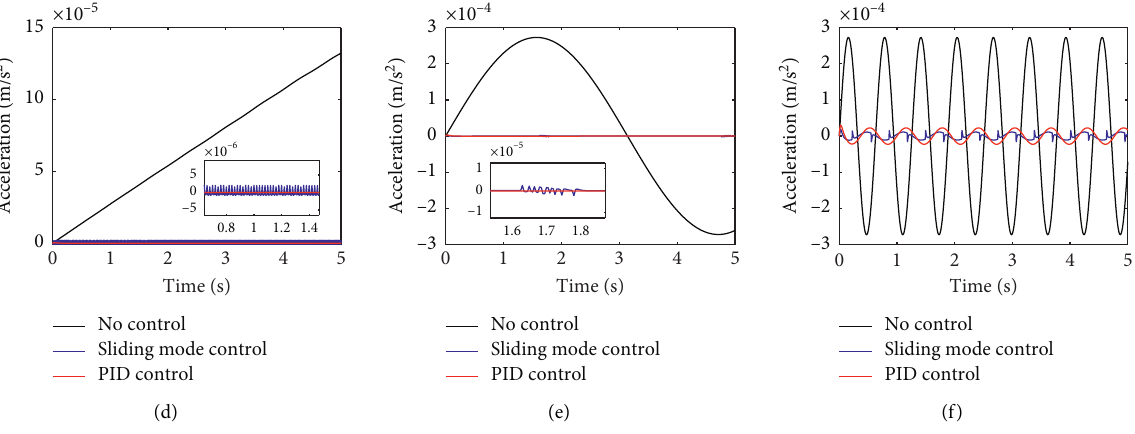
Figure 10: Floating platform acceleration and angular acceleration control.